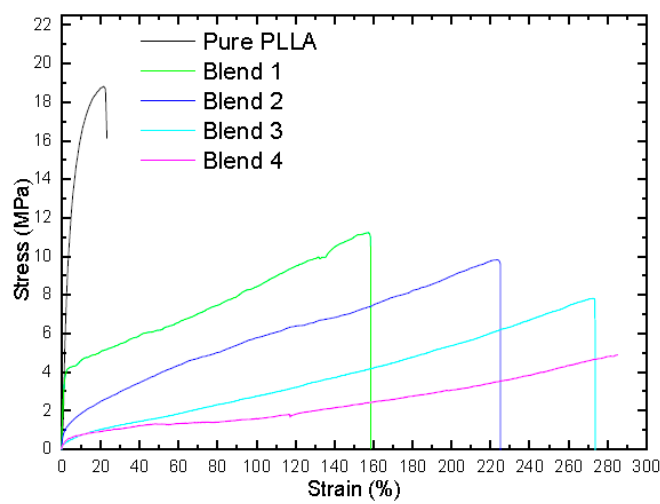
Figure 2. Mechanical testing of stress–strain for PLLA and its blends films at room temperature with a speed of 5 mm/min.